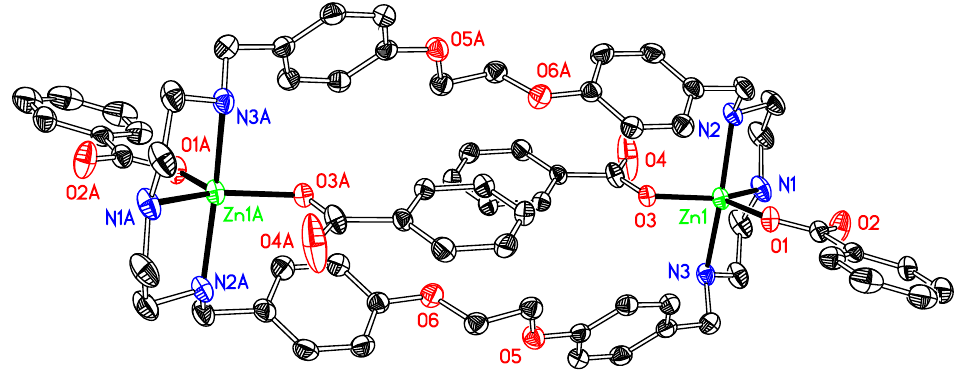
Figure 4. Thermal ellipsoid plot, drawn at the 30% probability level, of [Zn 2 (OCOPh) 4 L 1 ] ( 4 ) with atomic numbering scheme. All H atoms, along with the solvents are omitted for clarity. Symmetry codes: A 1 − x, − y, − z. Selected bond lengths (Å) and angles ( ◦ ): Zn1–N1 2.116(3), Zn1–N2 2.177(3), Zn1–N3 2.237(3), Zn1–O1 1.991(2), Zn1–O3 1.979(2); N1–Zn1–N2 80.80(13), N1–Zn1–N3 79.70(12),